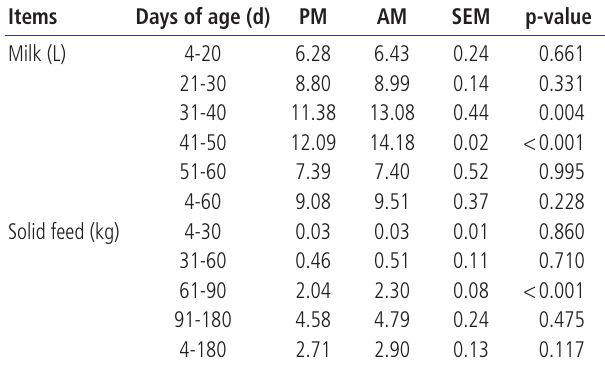
Table 2. The daily intake of milk and starter of calves fed pasteurized and acidified milk ad libitum Items